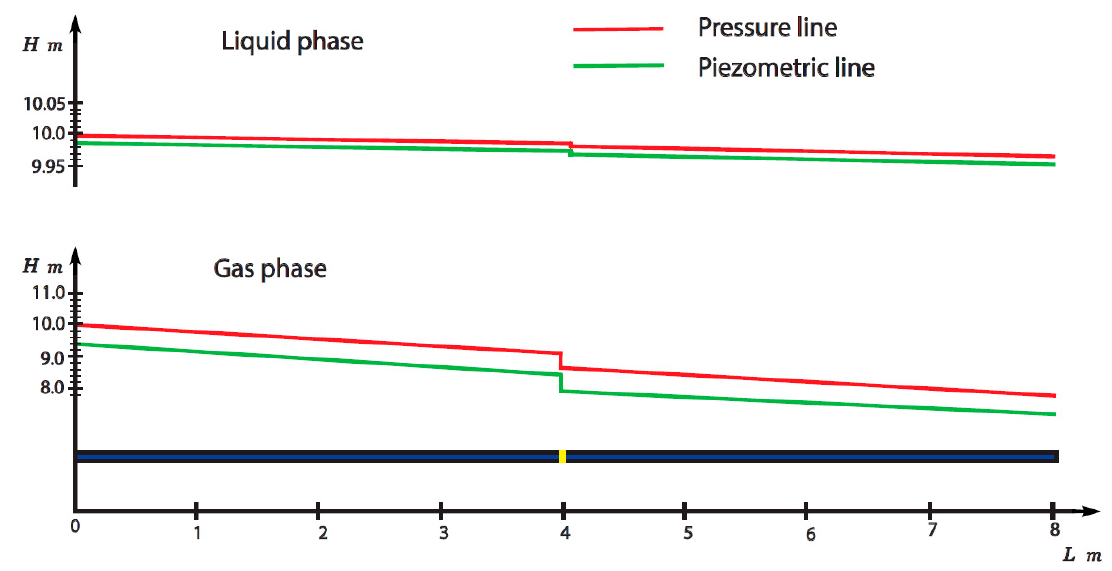
Figure 9. Pressure and piezometric lines for gas and liquid phases (the pipeline with the mesh partition).